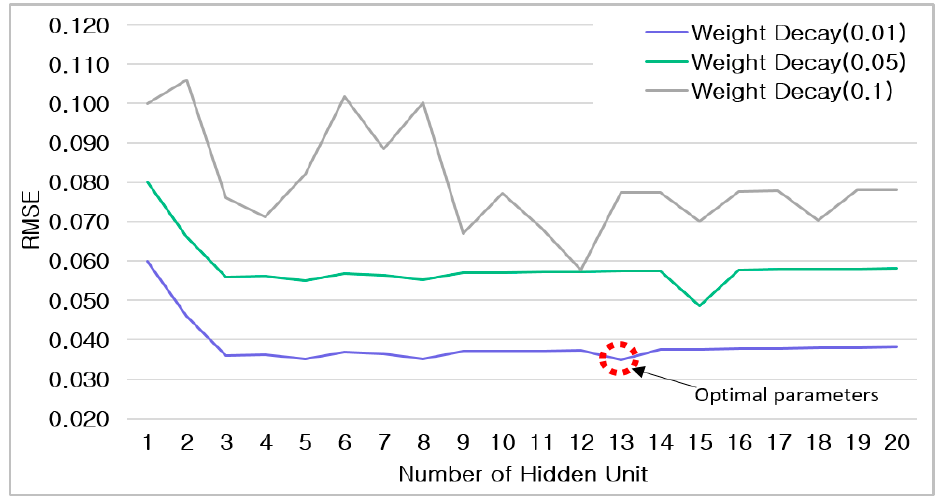
Figure 4. Selection of optimal parameters of artificial neural networks.